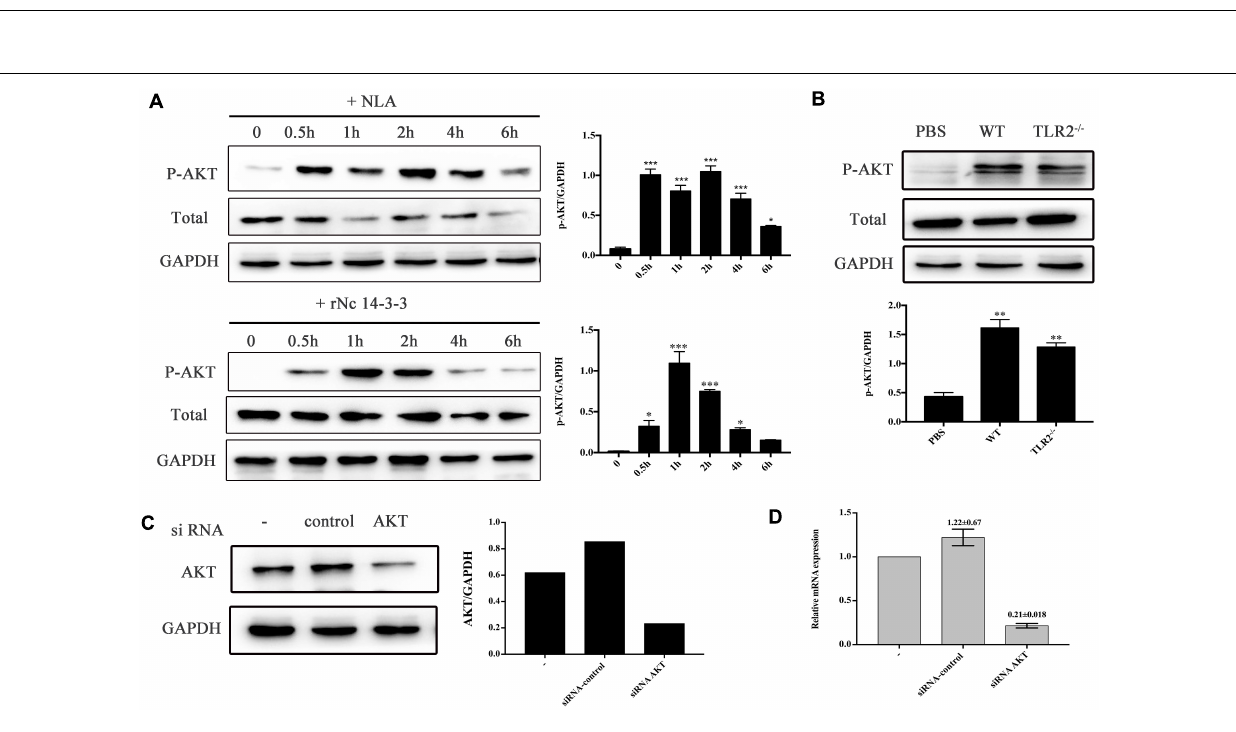
FIGURE 6 | Recombinant Nc14-3-3 activates AKT signaling pathways in WT and TLR2 − / − mouse PMs. (A) The phosphorylation levels of AKT in WT mouse PMs were determined by Western blotting after rNc14-3-3 or NLA treated for the indicated times. The phosphorylation of AKT was significantly increased at 1 h and the relative levels of the signals from the western blotting in panel. (B) The production of phosphorylation AKT in the WT and TLR2 − / − mouse PMs was measured by Western blotting after incubated with rNc14-3-3 protein for 1 h and the relative gray intensity analysis of the Western blotting. (C) WT mouse PMs were transfected with a small-interfering RNA targeting AKT for 24 h, and AKT protein levels were significantly reduced after RNA interference, as detected by Western blotting and the relative gray intensity analysis of the Western blotting. (D) The observed changes in AKT RNA levels after siRNA interference were consistent with protein levels. ∗ Data are expressed as the mean ± SD from three separate experiments. ∗ P < 0.05; ∗∗ P < 0.01; ∗∗∗ P < 0.001 for the treated groups versus the untreated or PBS